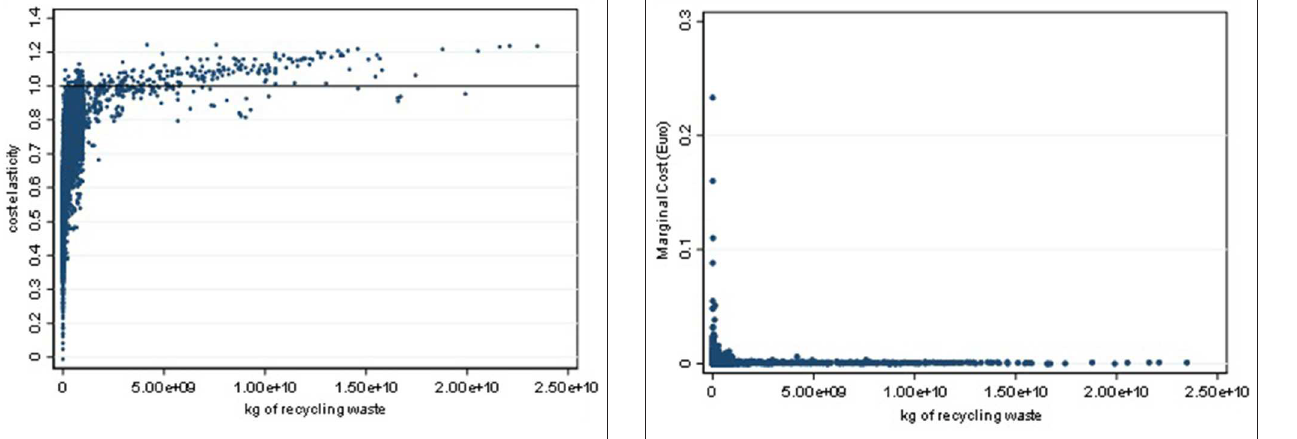
FIGURE 2 | Cost elasticities of recycling waste. FIGURE 3 | Marginal costs of recycling